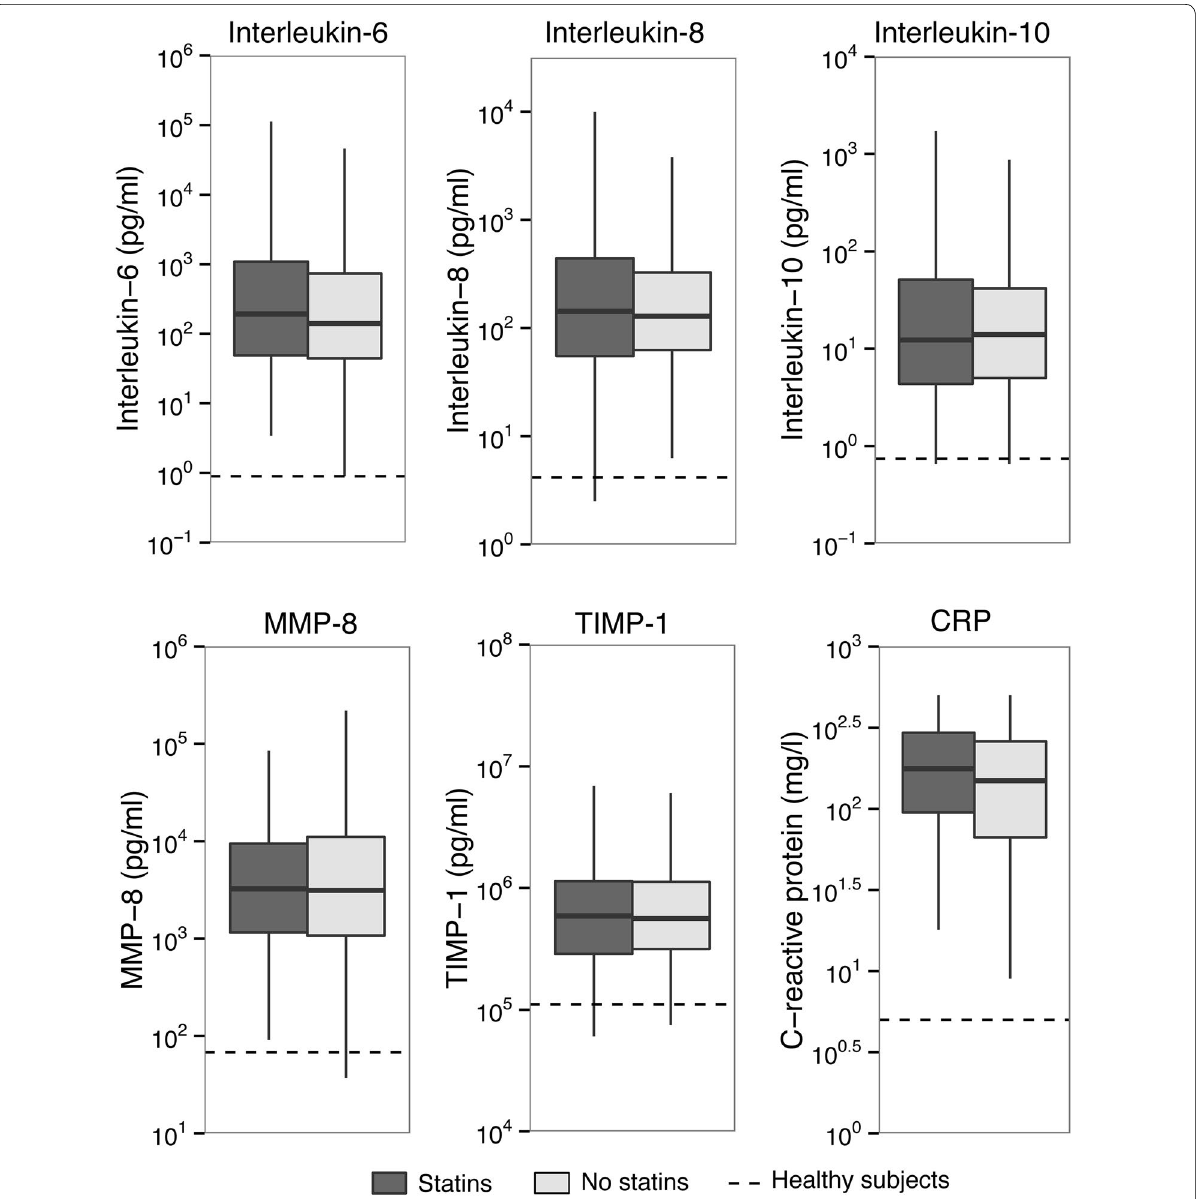
Fig. 1 Inflammatory responses in sepsis patients on ICU admission stratified according to statin use in the propensity-matched cohort. Data are expressed as box-and-whisker diagrams depicting the median and lower quartile, upper quartile and their respective 1.5IQR as whiskers (as speci- fied by Tukey). CRP levels were missing in 104 cases. Differences between groups were not significant. Dashed lines represent median levels in 27 healthy